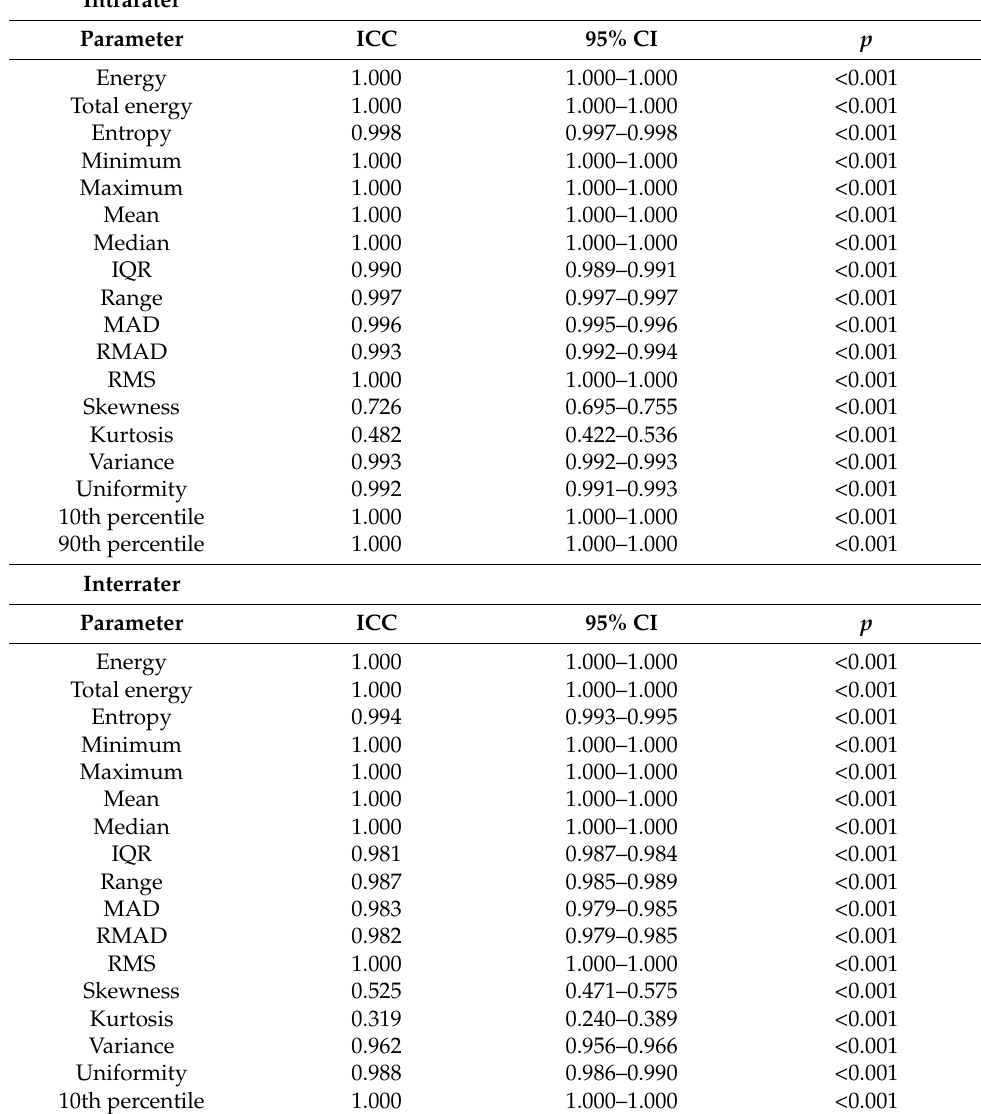
Table 3. Intrarater and interrater